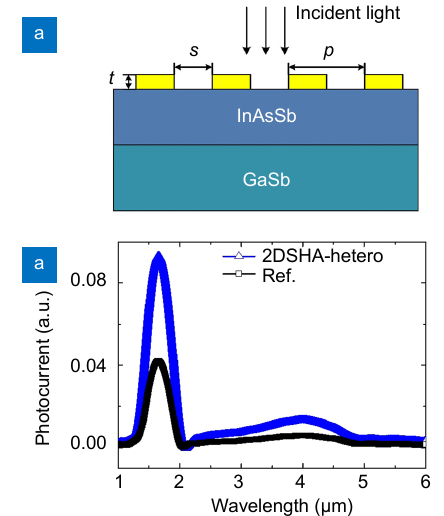
Fig. 5 | Plasmonic 2DSHA-hetero n-InAsSb/n-GaSb photodetector . (a) Schematic diagram of the device. (b) Photocurrent spectral meas- ured at room temperature. Figures reproduced from: (a) ref. 40 , Spring- er Science+Business Media New York; (b) ref. 38 .